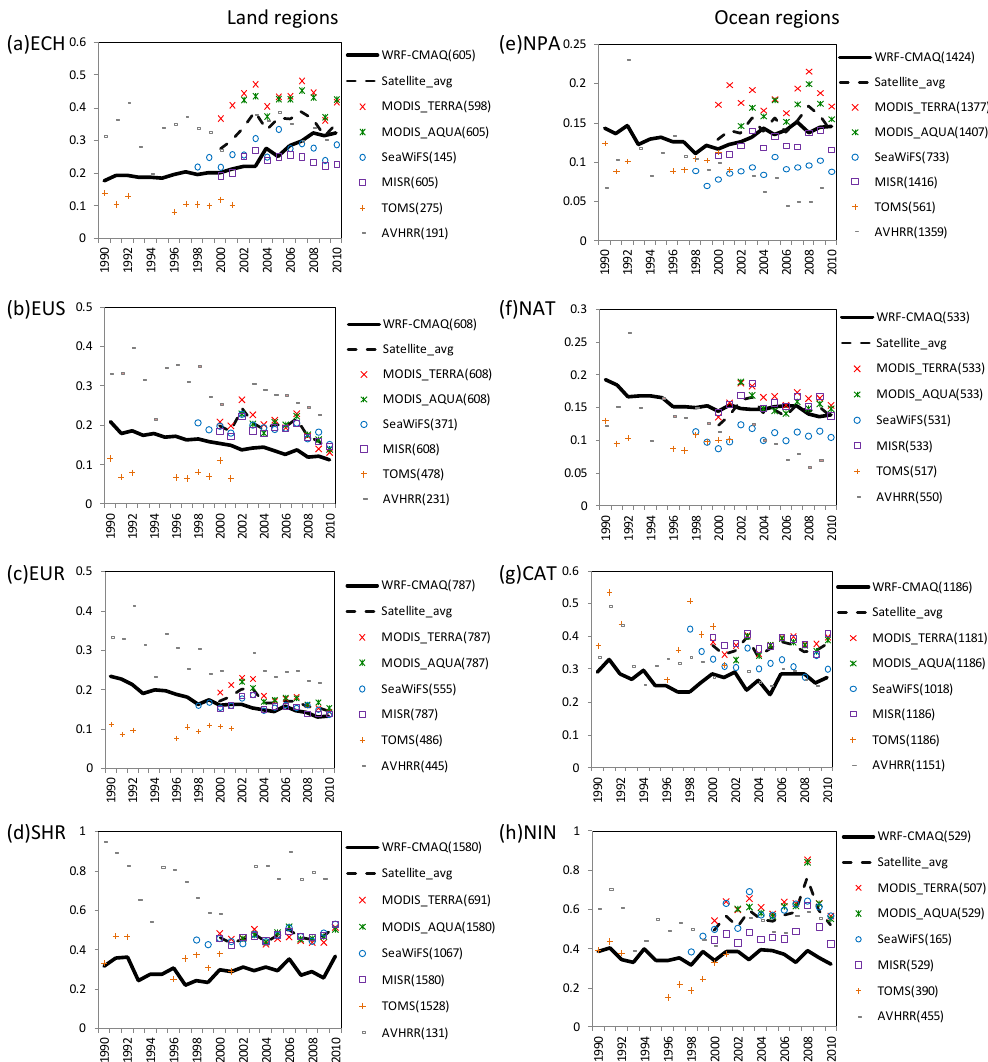
Figure 3. Temporal series of regional JJA-averaged AOD from satellite retrievals and WRF-CMAQ. The number of grids (>80% cover- age) involved in calculation is shown in the parentheses; only four EOS satellite-retrieved AODs, i.e., MISR, SeaWiFS, MODIS-Terra and MODIS-Aqua, were averaged into